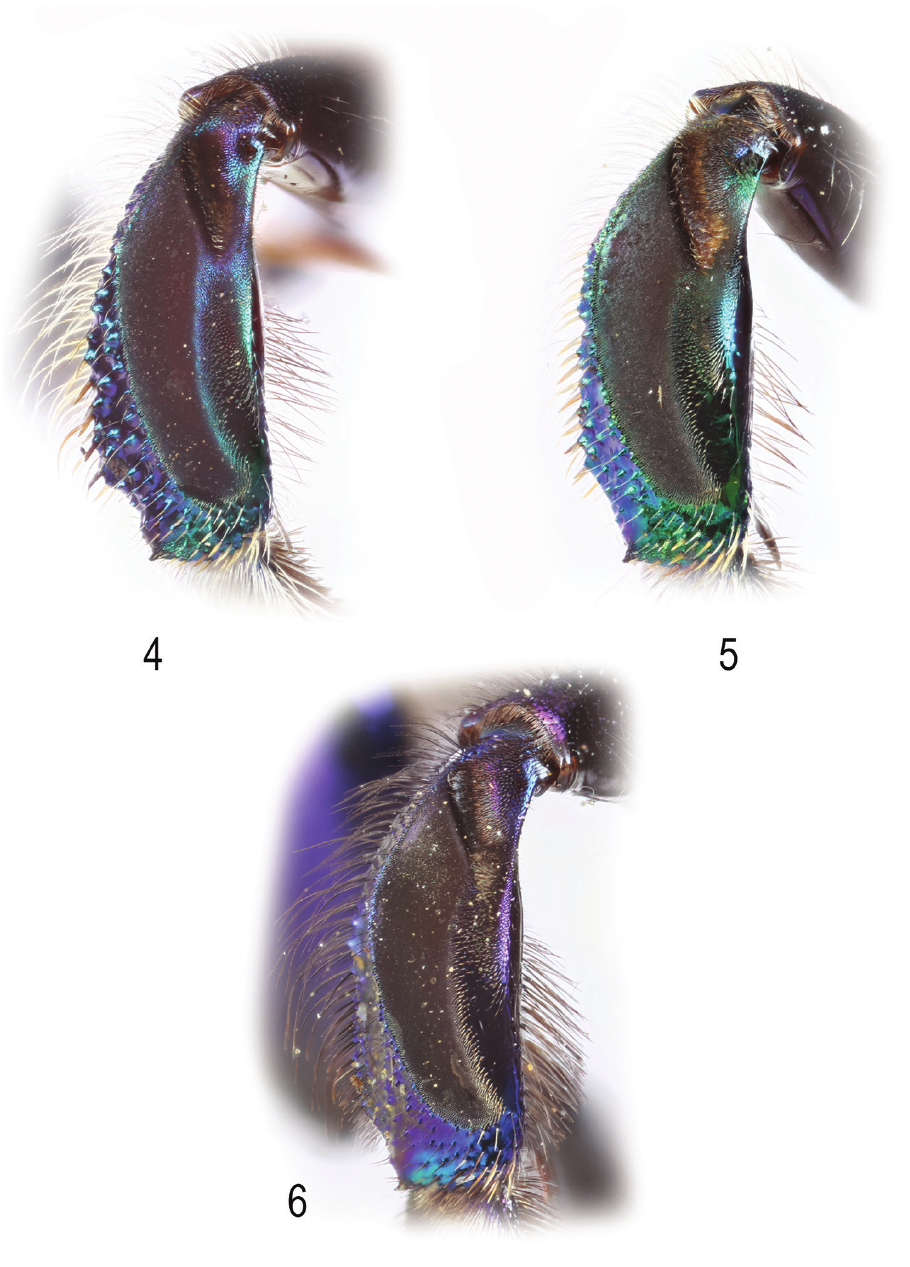
6 E. micheneri (paratype. Mexico: Jalisco, Mascota, KUNHM-ENT